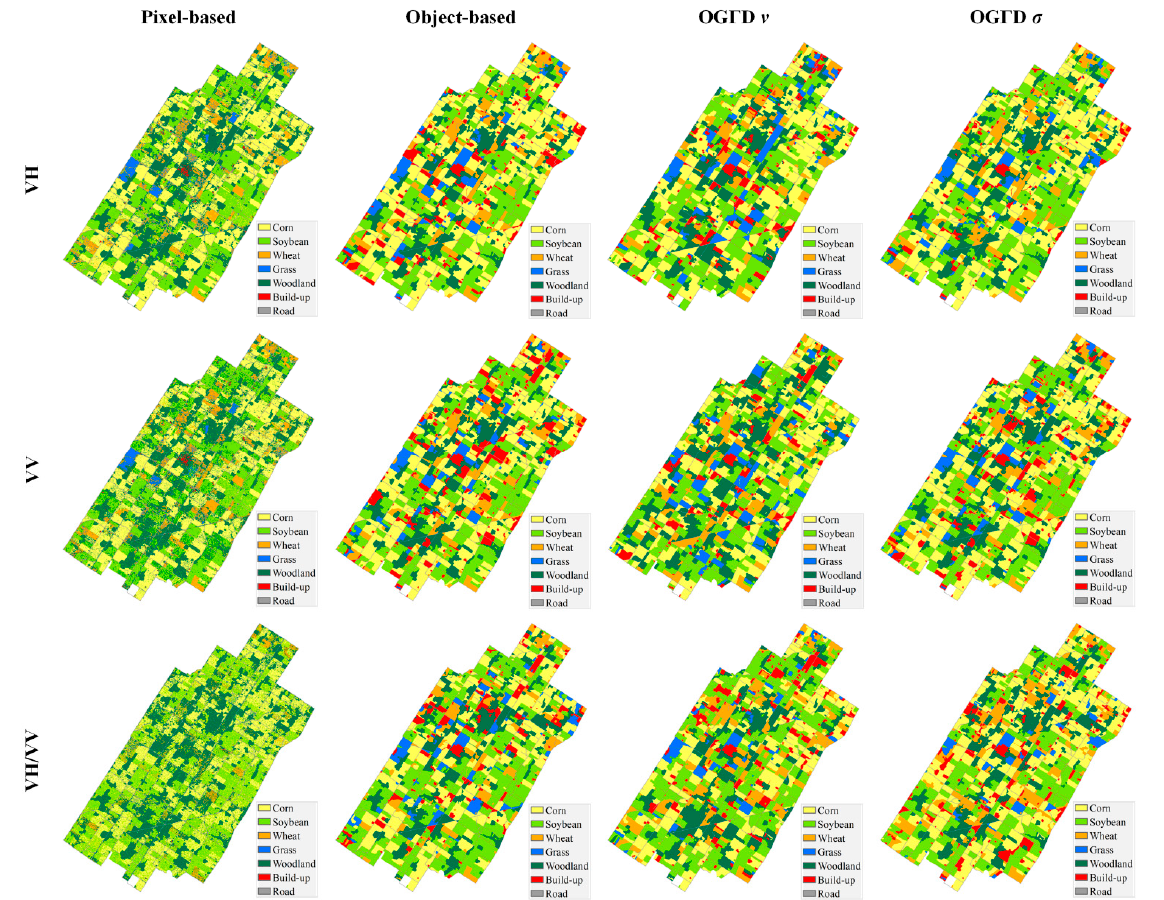
Figure 6. Crop classification results using a single type of feature. Each column is one feature type and each row is a polarization mode. Table 1. The quantitative evaluation results of crop classification using a single type of feature.